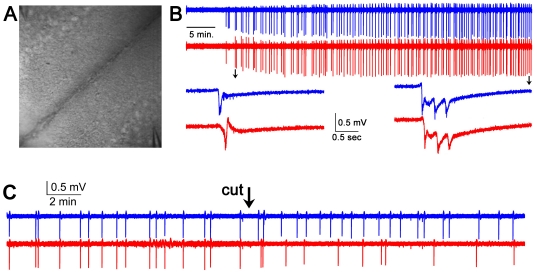
Electrophysiological extracellular recordings of bilateral EEs.(A) 410 µm×410 µm DIC view of the slice, showing the location of two extracellular recording electrodes in each hemisphere (upper left and lower right corners). The interhemispheric fissure forms the rightward slanting diagonal that roughly bisects the image. (B) Two simultaneous extracellular recordings, one hour long, and each from opposite hemispheres in layer 2/3 cingulate cortices show bilateral EEs. 20 µM bicuculline is added to the bath perfusion at the beginning of the recording. These recordings were highpass filtered at 0.2 Hz. Individual bilateral events indicated by arrows are temporally magnified below and are shown without highpass filtering. Sample rate = 5 kHz. Note that the number of events increases per unit time, and the number of afterdischarges per event increases. (C) Complete bisection of the corpus callosum in vitro abolishes bilateral temporal fidelity of EEs (15/15 bilateral events before the cut during 15 minutes of recording, 0/20 bilateral events after the cut during 15 minutes of recording, both with reference to the “blue” recording, p<0.01, Chi Square test of proportions). During a dual extracellular recording in 20 µM bicuculline, a small blade over the corpus callosum is lowered with a micromanipulator, severing all callosal connections during the recording.